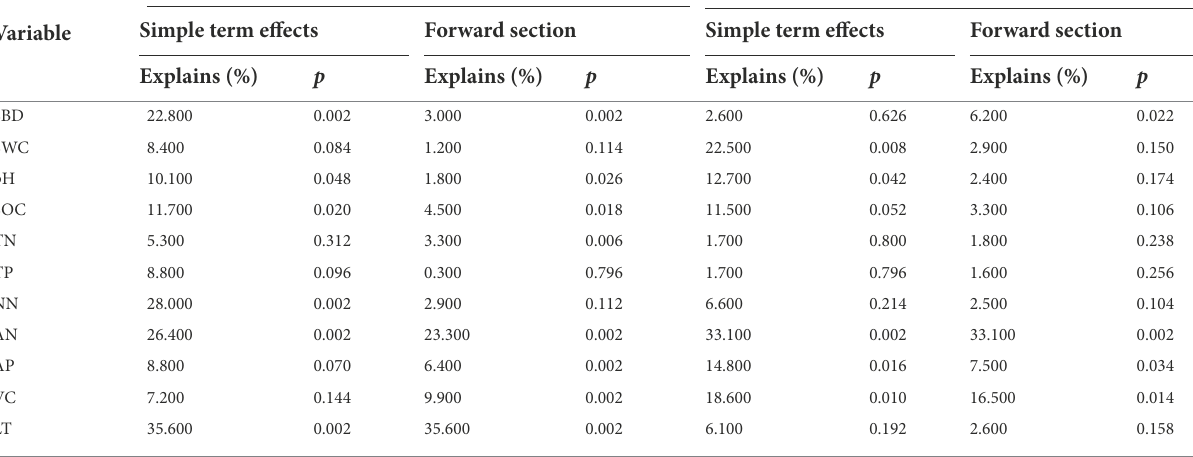
TABLE 3 Simple term effects and forward selection of environmental variables based on Monte Carlo permutation tests from the redundancy analysis (RDA).